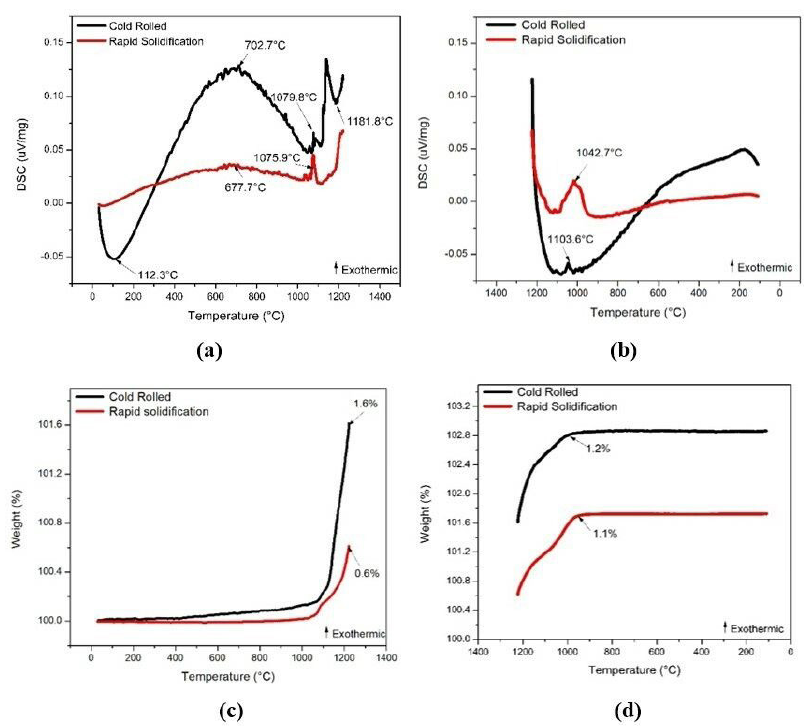
Figure 9. Thermal analysis for austenitic 316L stainless steel in the cold rolled and rapid solidification conditions, using synthetic air as carrier gas. (a) DSC heating curves; (b) DSC cooling curves; (c) TG heating curves; (d) TG cooling curves.